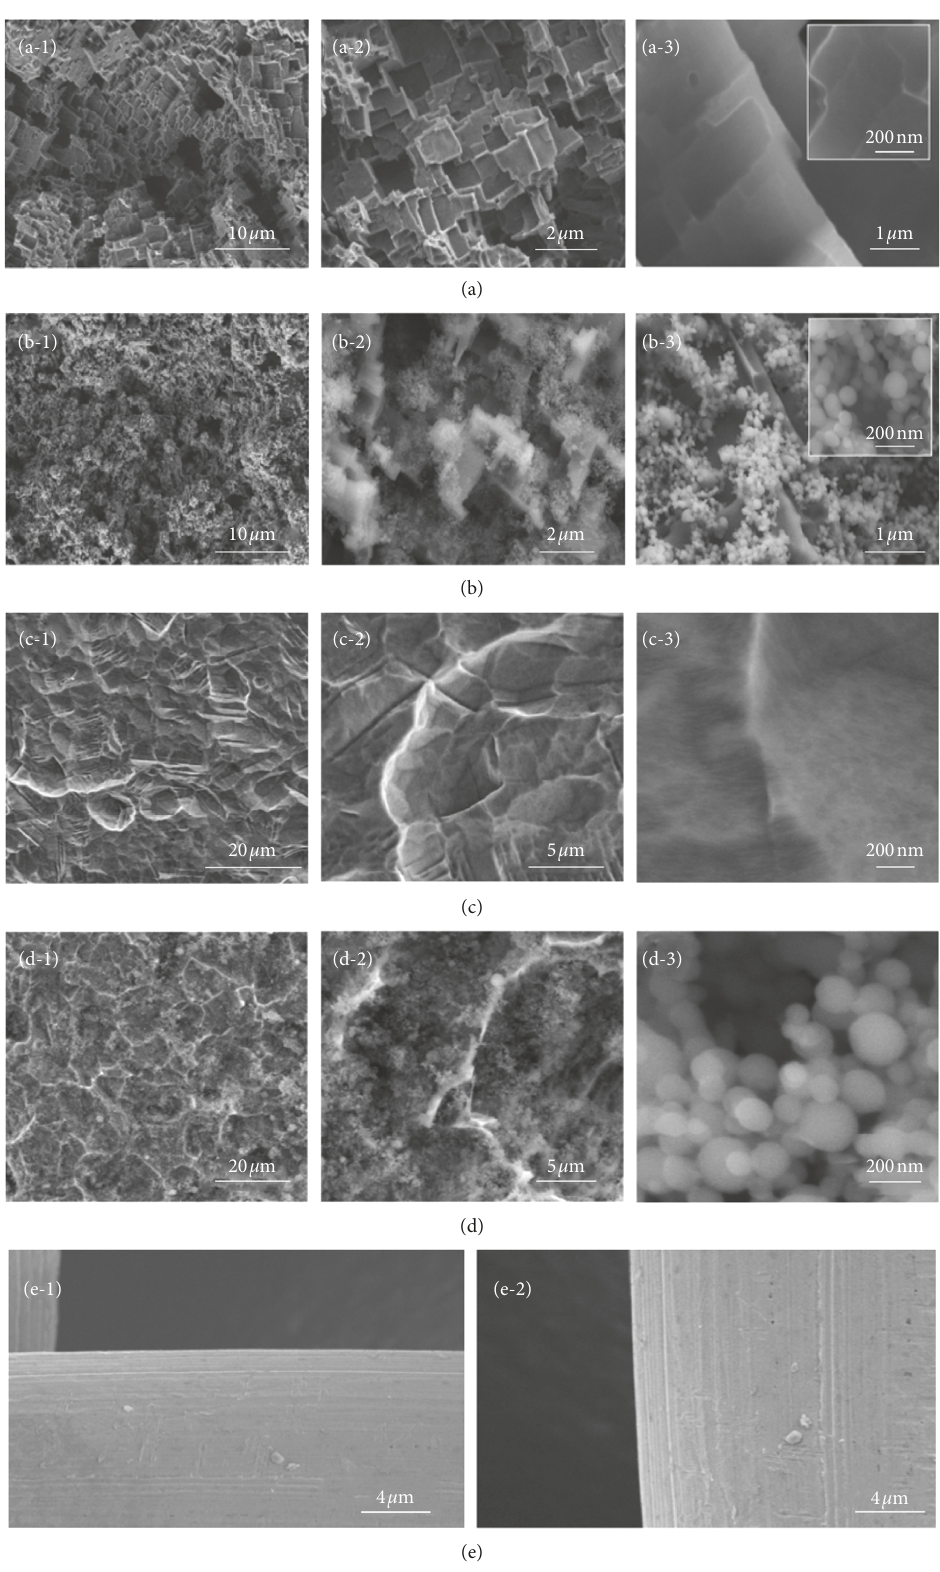
Figure 1: Low and high FESEM images of the (a) Al alloy and (c) stainless steel after etching process, (b) Al alloy and (d) stainless steel after the combination of etching and EPD treatments, (e) polished Al alloy